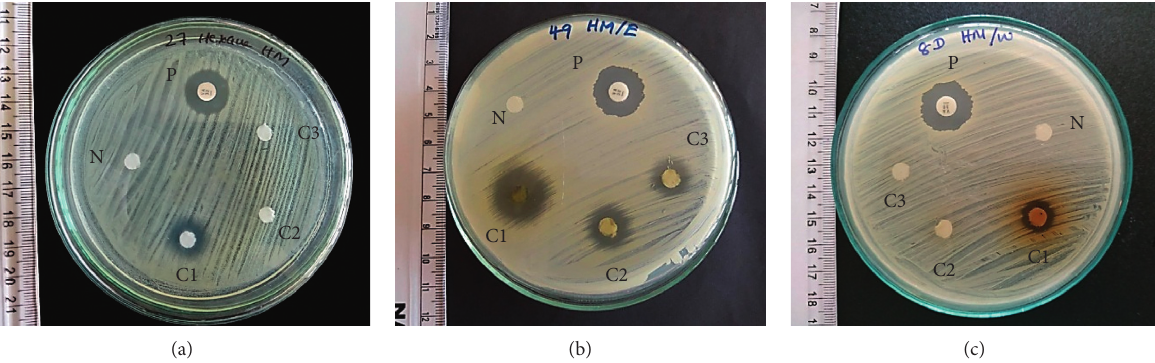
Figure 2: Inhibitory zones of crude extracts of E. divaricata : (a) hexane extract; (b) ethanol extract; (c) water extract. P: positive control; N: negative control; C1: crude extract; C2: 10-fold dilution of crude extract; C3: 100-fold dilution of crude extract. Table 1: Diameter values of the disk diffusion assay of E. divaricata and V. zizanioides against MSSA and MRSA strains. Inhibition zone diameter (mm) Extract Concentration